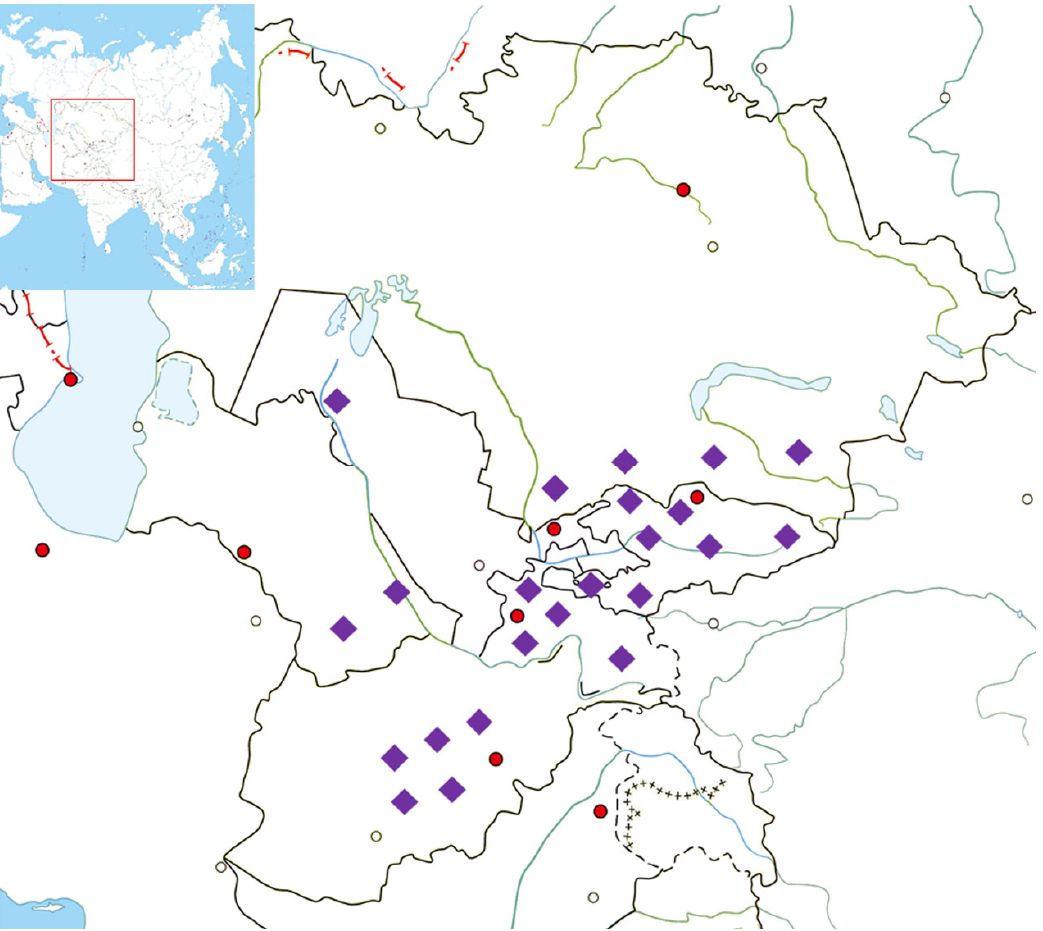
Figure 1. Approximate sampling locations. Detailed information is provided in Table S1. Purple rhombi indicate the sampling locations. Red and transparent circles indicate the capitals and major cities of countries, respectively.